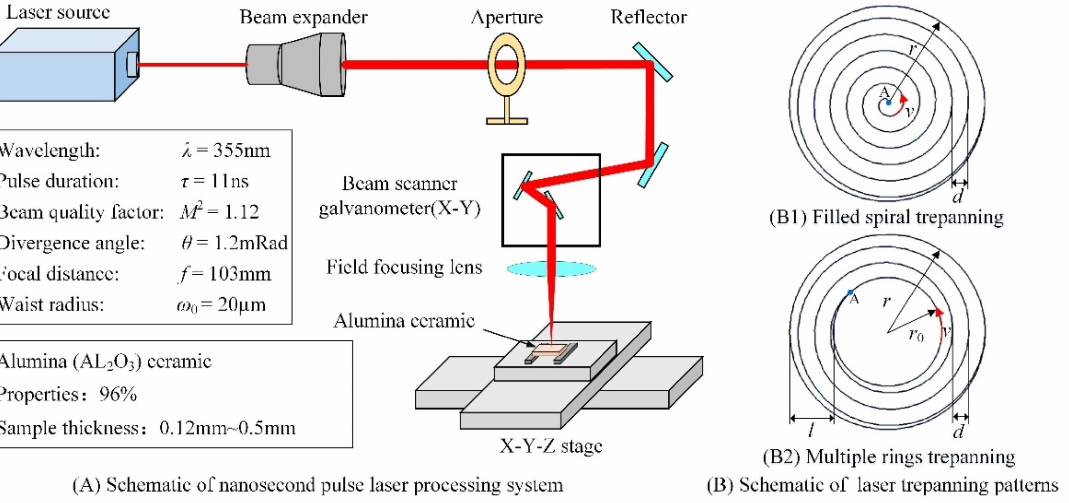
Figure 1. Schematics of nanosecond pulse laser processing system ( A ) and laser trepanning patters ( B